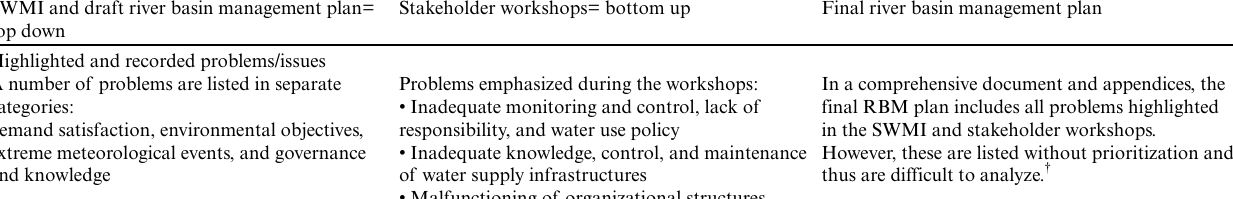
Table 1. Discrepancies and congruencies between top-down and bottom-up planning diagnosis and identified measures SWMI and draft river basin management plan= Stakeholder workshops= bottom top down